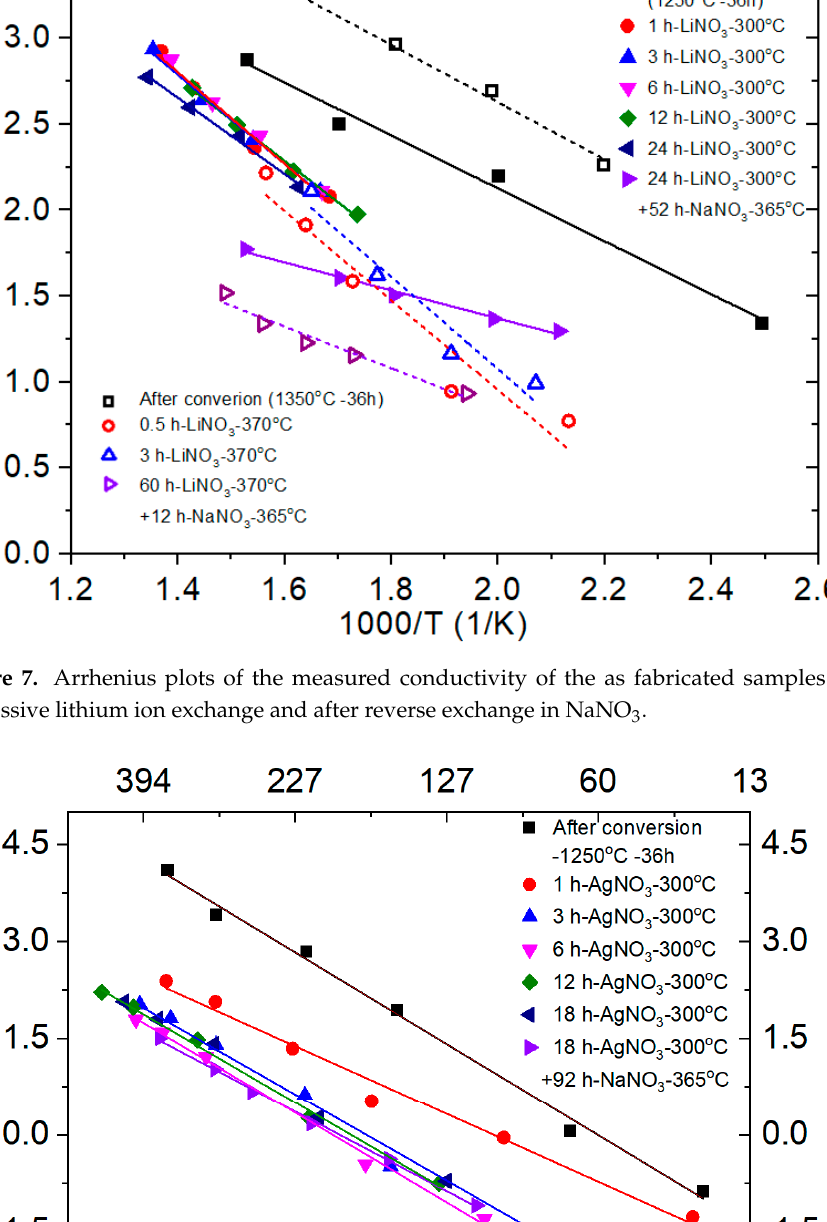
Figure 9. ( a ) A sample of Ag- β″ -alumina + YSZ. ( b ) The sample after heat treating at 900 °C in air showing metallic color. The process occurs because reaction (1) is thermodynamically favored. The formation of Ag- β″ -alumina + YSZ by ion exchange in molten AgNO 3 starting with Na- β″ -alumina + YSZ is thermodynamically favored since it is only a reaction involving entropy change with essentially no enthalpy change. This makes it possible to make many β″ -alumina capable of transporting other cations by ion exchange, even though such phases may not